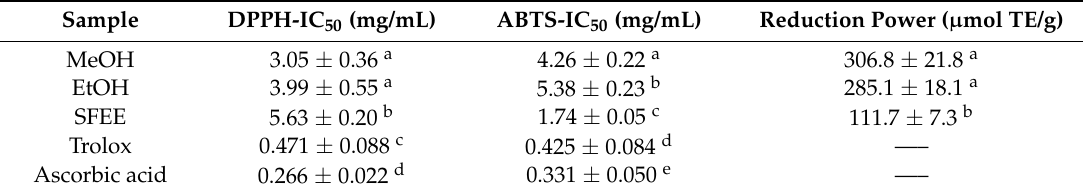
Table 3. Antioxidant activity of 2,2-diphenyl-1-picrylhydrazyl (DPPH), 2,2-azino-bis(3-ethylbenzthiazoline- 6-sulfonic acid (ABTS) (IC 50 in mg/mL), and reducing power ( µ mol TE/g) of basil extracts obtained by different extraction